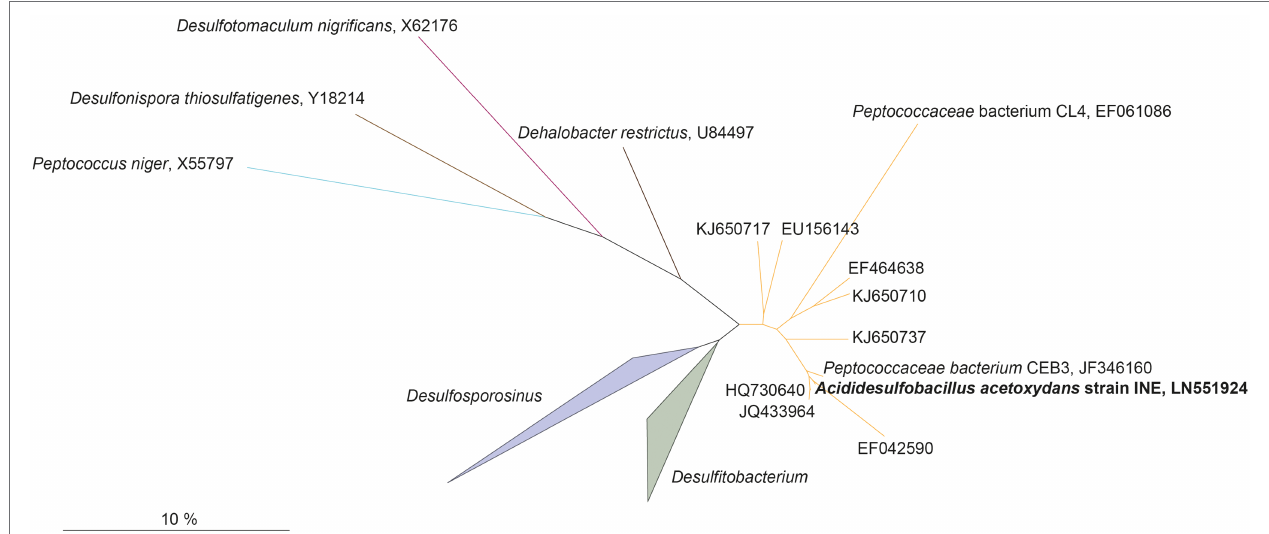
FIGURE 2 | Maximum-likelihood tree showing phylogenetic affiliation of 16S rRNA gene sequences of Acididesulfobacillus acetoxydans (in bold) with related environmental sequences found in acidic environments, and closely related species in the Peptococcaceae family of the Firmicutes phylum. The accession numbers represent sequences retrieved from different acid drainage environments. KJ650710, KJ650737, or KJ650717: sulfidic mine tailings dumps in Botswana; EF042590: an abandoned copper mine in Odiel (Huelva, Spain); HQ730640, JQ433964: Tinto River sediments; EU156143: a thermal spring in Yellowstone National Park (WY, United States); EF464638: acidic enrichment cultures. JF346160 and EF061086: Peptococcaceae bacteria CEB3 and CL4. Scalebar indicates 10% sequence